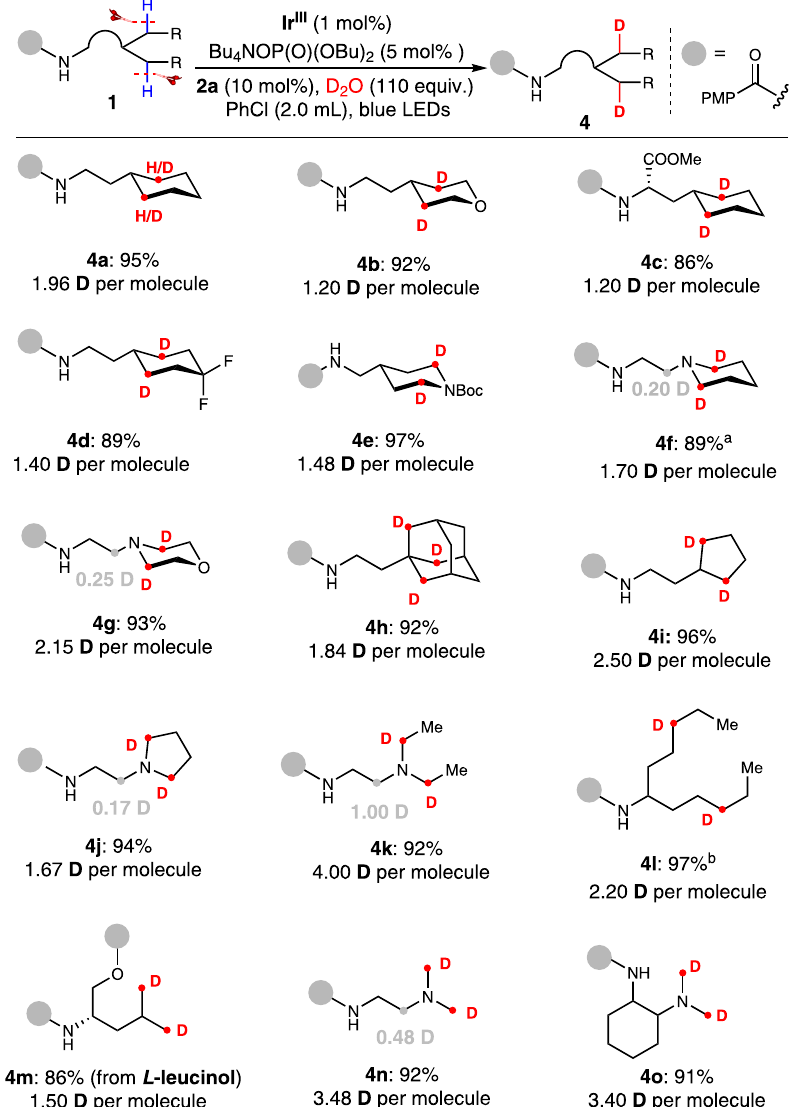
Fig. 3 Multi-deuteration of C(sp 3 )-H bonds. Reaction conditions: Ir III (1 mol%), Bu 4 NOP(O)(OBu) 2 (5 mol%), 2a (10 mol%), 1 (0.1 mmol), D 2 O (110 equiv., 0.2 mL), PhCl (2.0 mL), blue LEDs, 24 h, ambient temperature (with a fan to cool), in argon atmosphere. Isolated yields are shown and